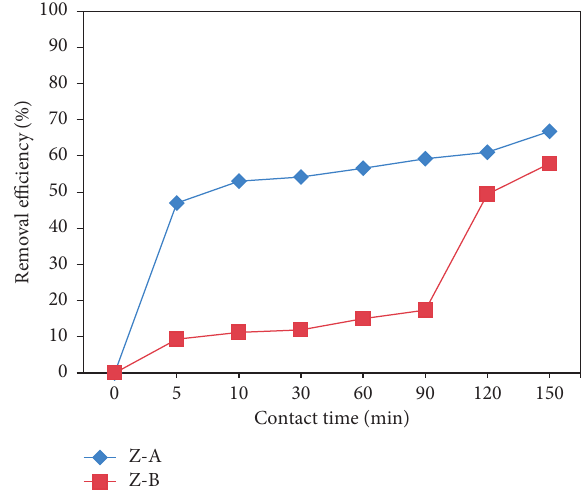
Figure 4: Effect of contact time on removal efficiency of Z-A and